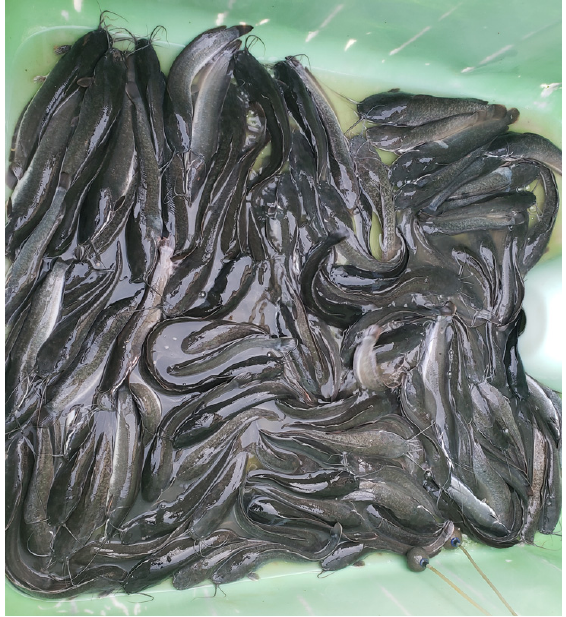
Figure 7. African Catfish yield of the SANFU II RAS in one production cycle of 4 months. Source: Authors.